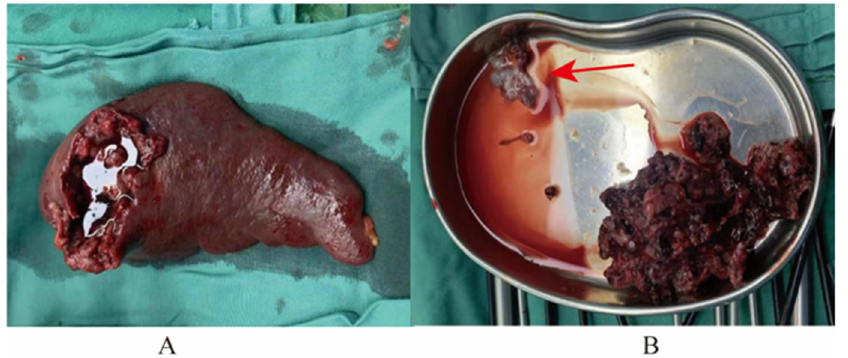
Figure 3. Specimens obtained in the operation. ( A ) Spleen. ( B ) Villous-like tissue (solid red arrow) and other tissues.